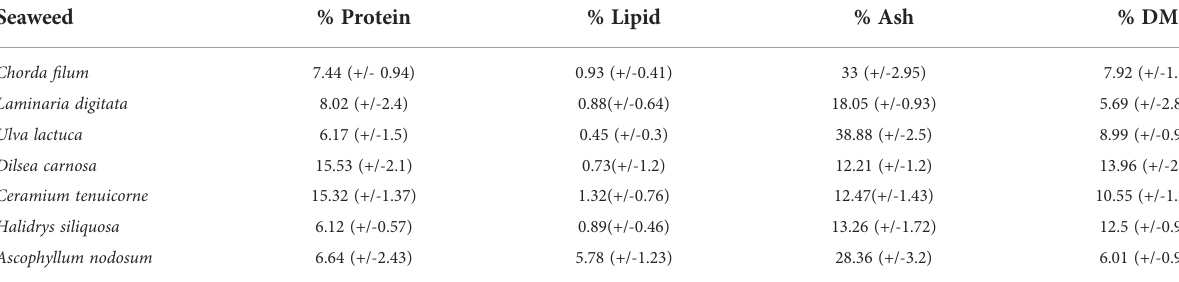
TABLE 2 Proximate compositional analysis of Swedish seaweeds. Seaweed %